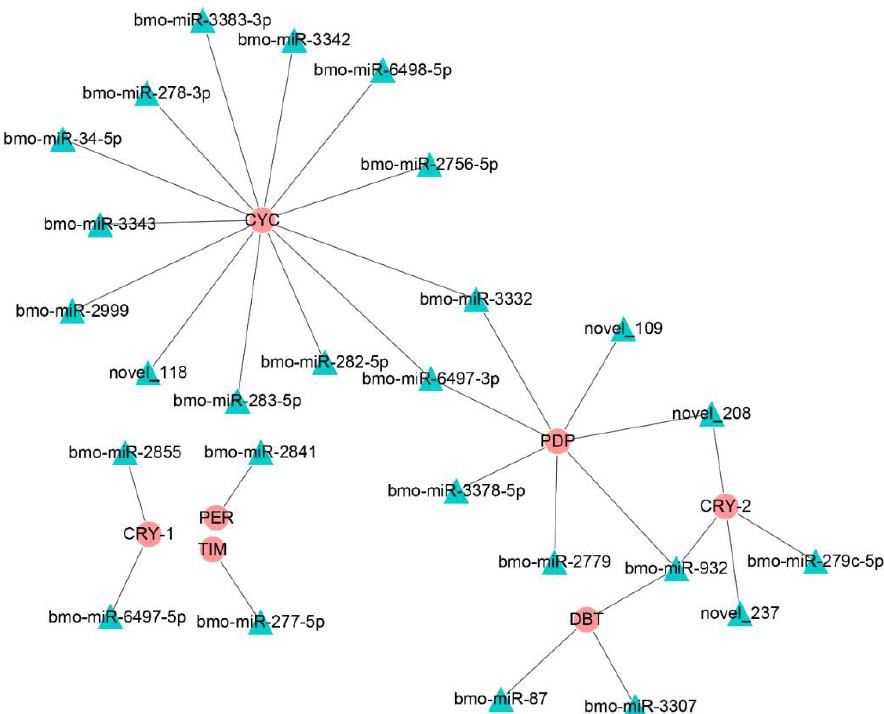
Figure 5. The regulatory networks formed by the Drosophila homologous genes of the circadian clock-fly pathway in the silkworm and differentially expressed miRNAs. The round red nodes represent the circadian clock genes; the green triangular nodes represent differentially expressed miRNAs.